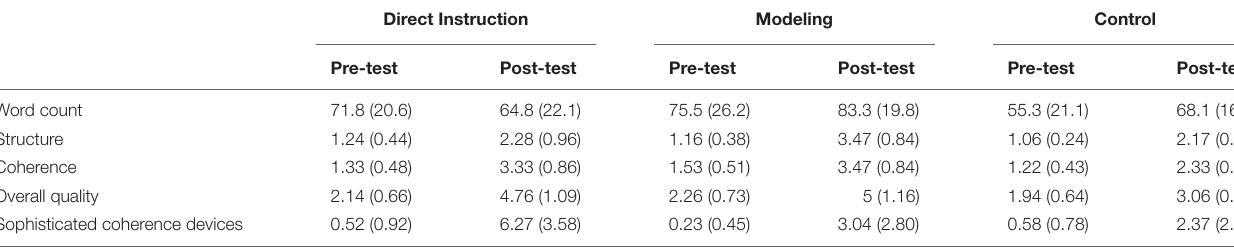
TABLE 3 | Effects of intervention on performance in the collaborative writing assessment task.